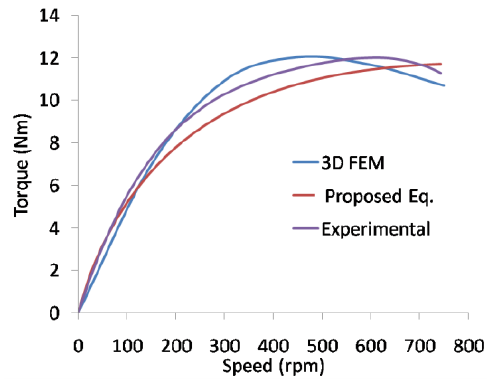
Figure 8. Experimental comparison.